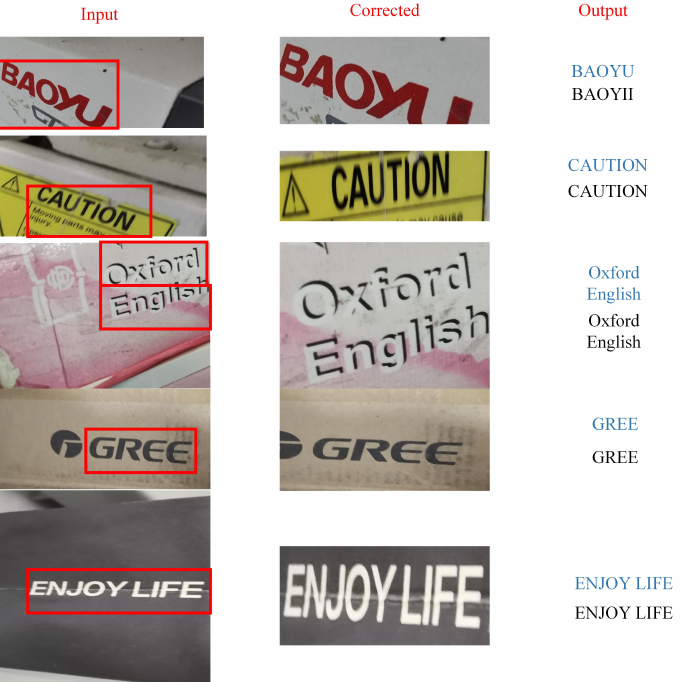
Figure 12. Result output diagram.